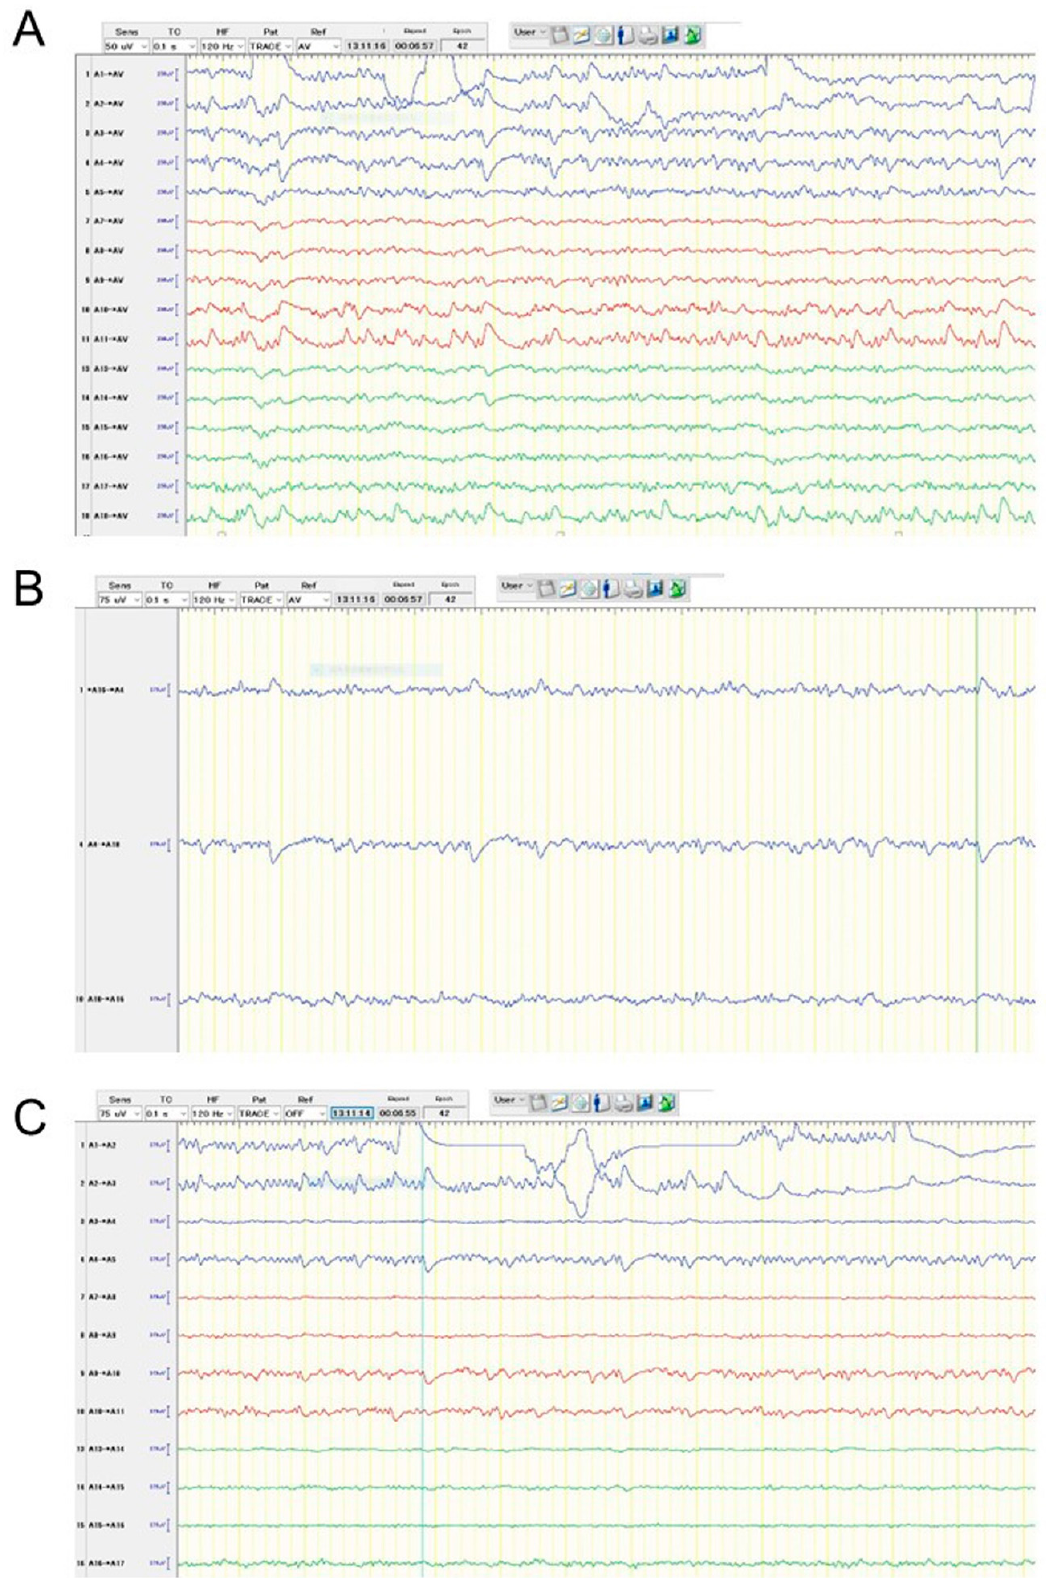
Figure 3. Intraoperative EEG patterns before resection of the tumor according to the different montages: average potential reference ( A ), bipolar recording in similar levels of depth among three deep electrodes ( B ), and bipolar recording in each deep electrode ( C ). There were 6 electrodes in